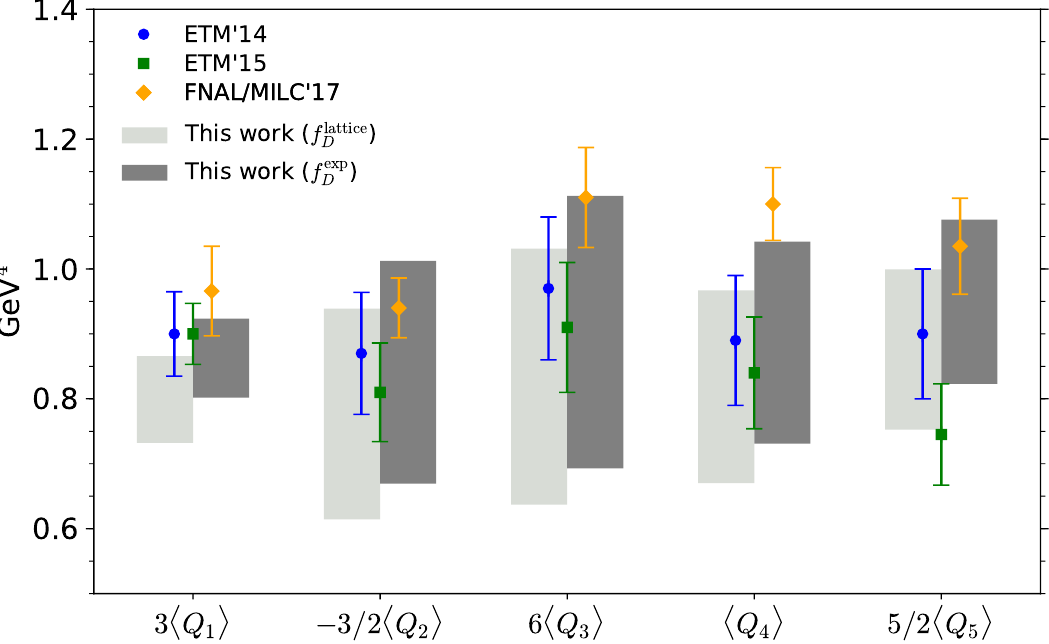
Figure 7 . Comparison of our results for the (cid:1) C = 2 matrix elements at the scale 3 GeV to the lattice values of ETM’14 [30], ETM’15 [31] and FNAL/MILC’17 [32]. The values for the matrix elements of the ETM collaboration are extracted from (cid:12)gure 16 of